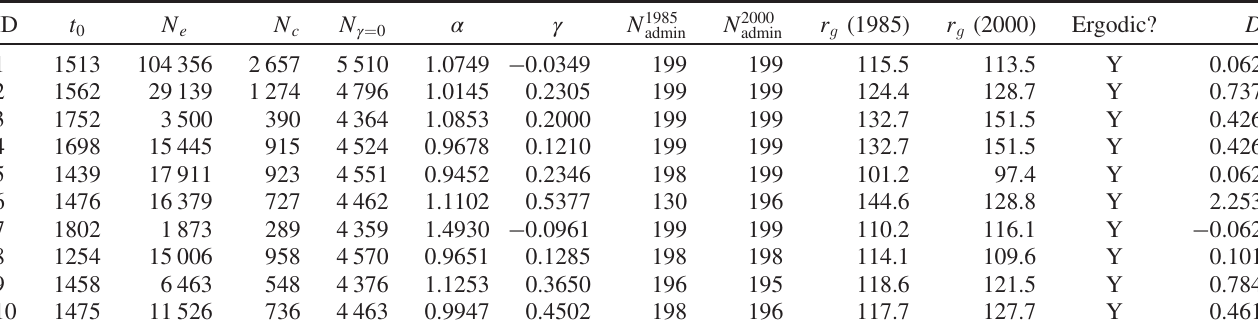
TABLE I. Number of entries and other information available in each jokbo , values that we determined by using additional data that we obtained from other sources, and a summary of some of our computational results for the clan corresponding to each jokbo . For each jokbo , we indicate the ID (1 – 10), the year t 0 of its earliest entry, its number of entries N , and the number of distinct clans (including at e least one bride for each clan) N among those entries [21]. The quantity N γ gives the number of clans from the 2000 census (which is c ¼ 0 4 303) plus the number of clans in each jokbo that are not already in the census. We can use these N γ clans in the gravity model when ¼ 0 γ ¼ 0 (i.e., for the population-product model, which is applicable without geographical information) and α ¼ 1 . (See the discussion in Appendix B.) We also indicate the best values for the fitting parameters α and γ of the gravity model in Eq. (1). We apply this fit to the brides ’ side of marriages, and we calculate these values by minimizing the sum of squared differences using the SCIPY . OPTIMIZE package 1 . 0 in our computations). We compute the number of administrative regions N in P YTHON [35] (with initial values of α ¼ γ ¼ a G ¼ admin in which the clan that corresponds to each jokbo (i.e., the grooms ’ side) appears based on census data from 1985 and 2000. We use the census data to compute a radius of gyration r (km) for both 1985 and 2000 and to estimate a diffusion constant D ( km 2 = year) for g ≥ 150 to be ergodic (see Fig. 5). Based on this definition, all diffusion of clans between those two years. We consider clans with N 2000 admin ten clans in the jokbo data are